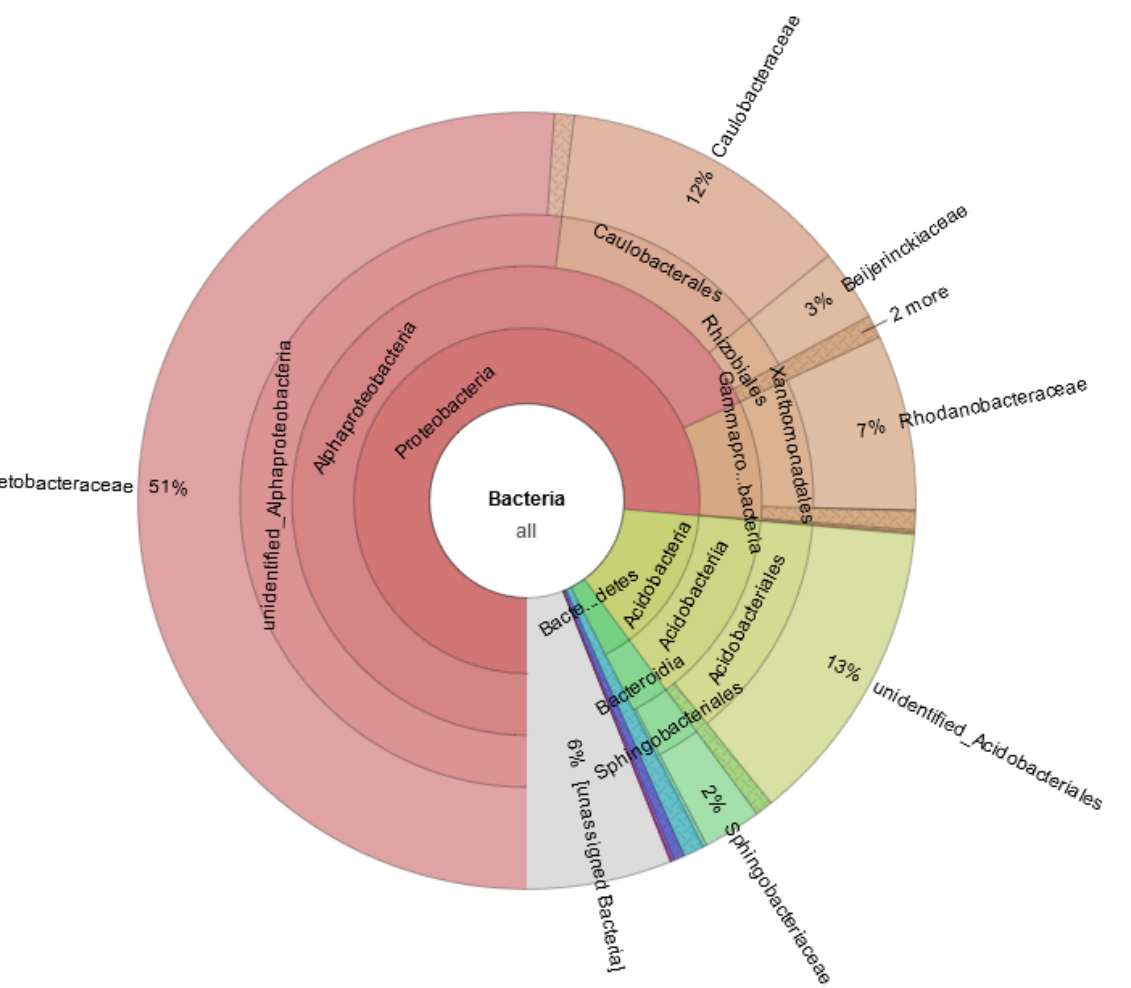
Figure 6. Taxonomic compositions of 75 OTUs at different phylogenetic levels using MetaCoMET. Circles go from inside to outside, indicating different taxa (kingdom to genus). The percentage represents the relative abundance of OTUs.